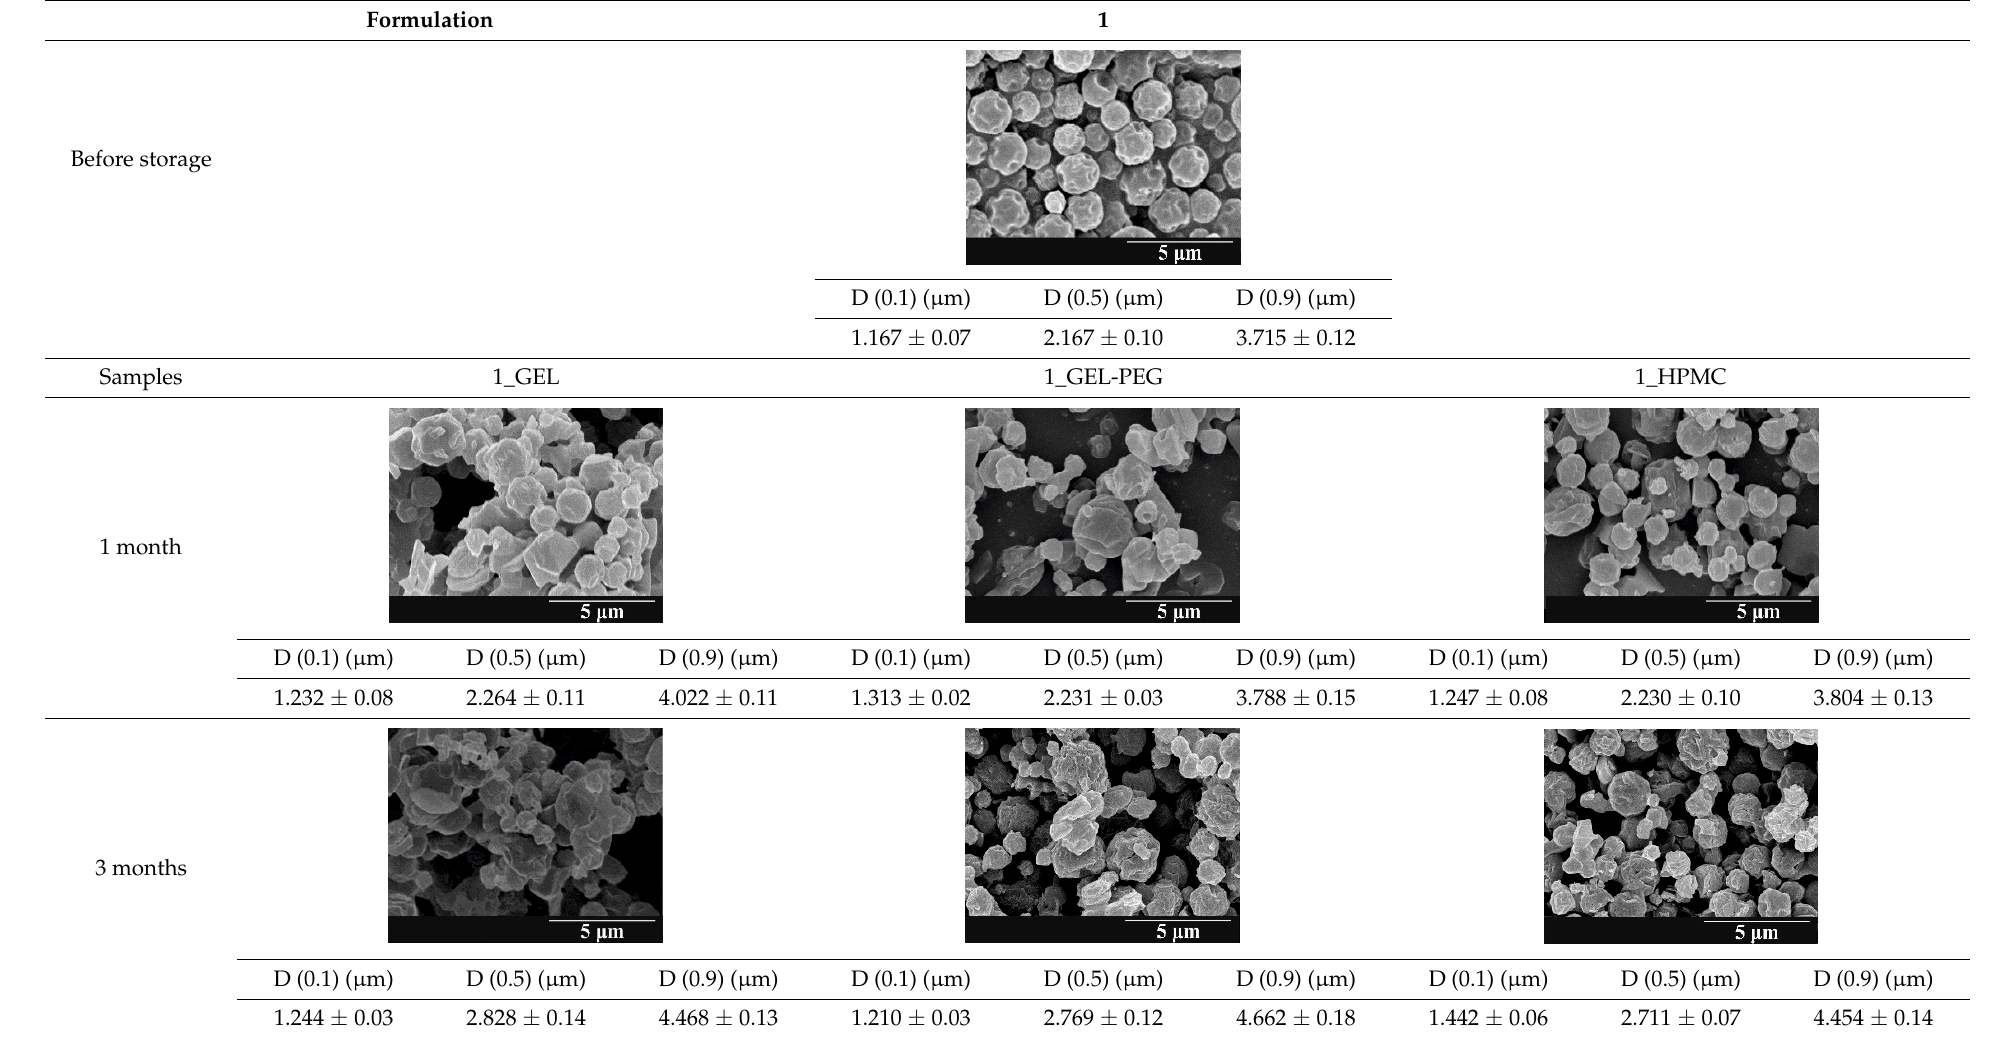
Table 5. Particle size distribution and morphology of the carrier-free samples during the stability test.